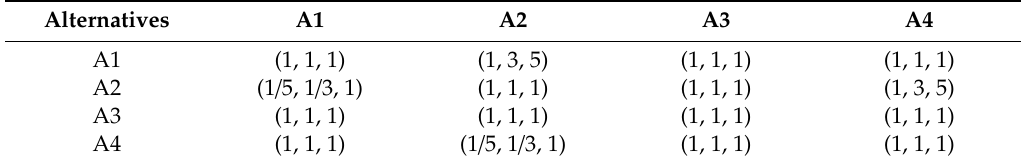
Table 17. Evaluation with respect to the maintenance